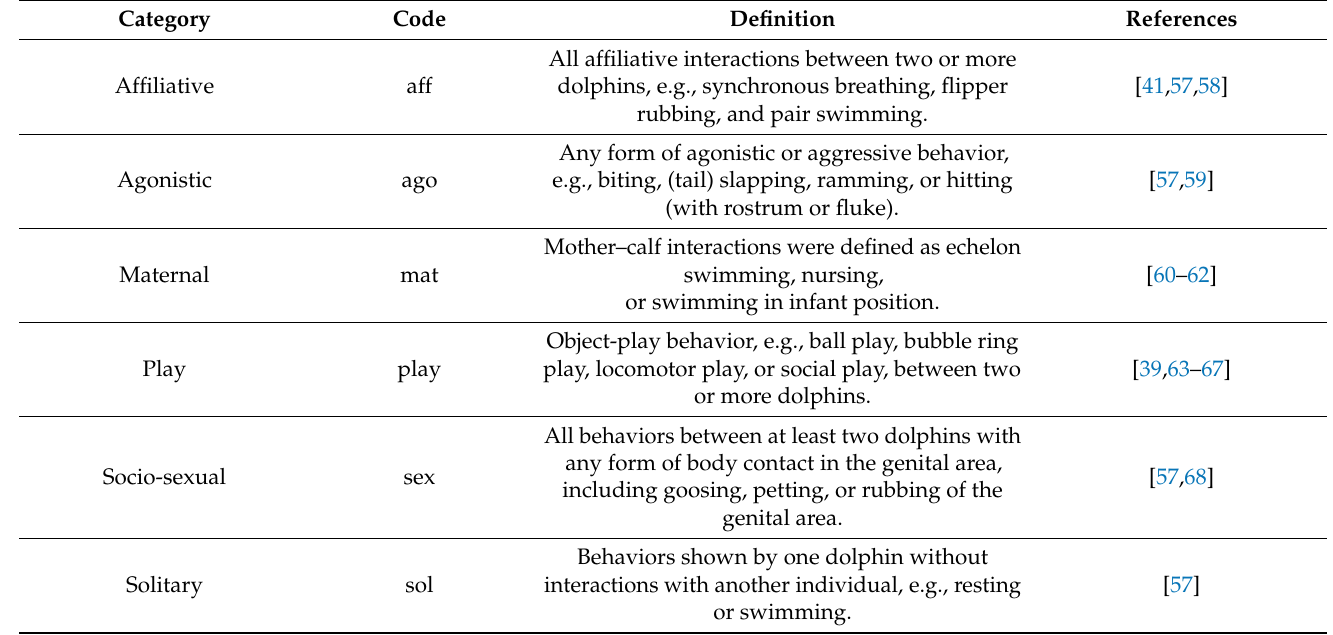
Table 2. Catalog of behavioral categories that were used during scan sampling. For each behavioral category, some examples are shown.